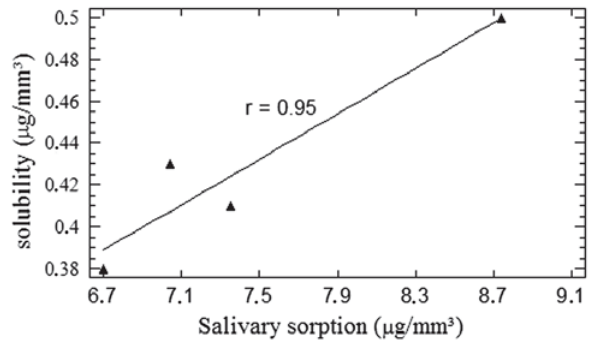
FIGURE 2- Regression line (linear model) of solubility plotted against the salivary sorption (r = 0.95, p <